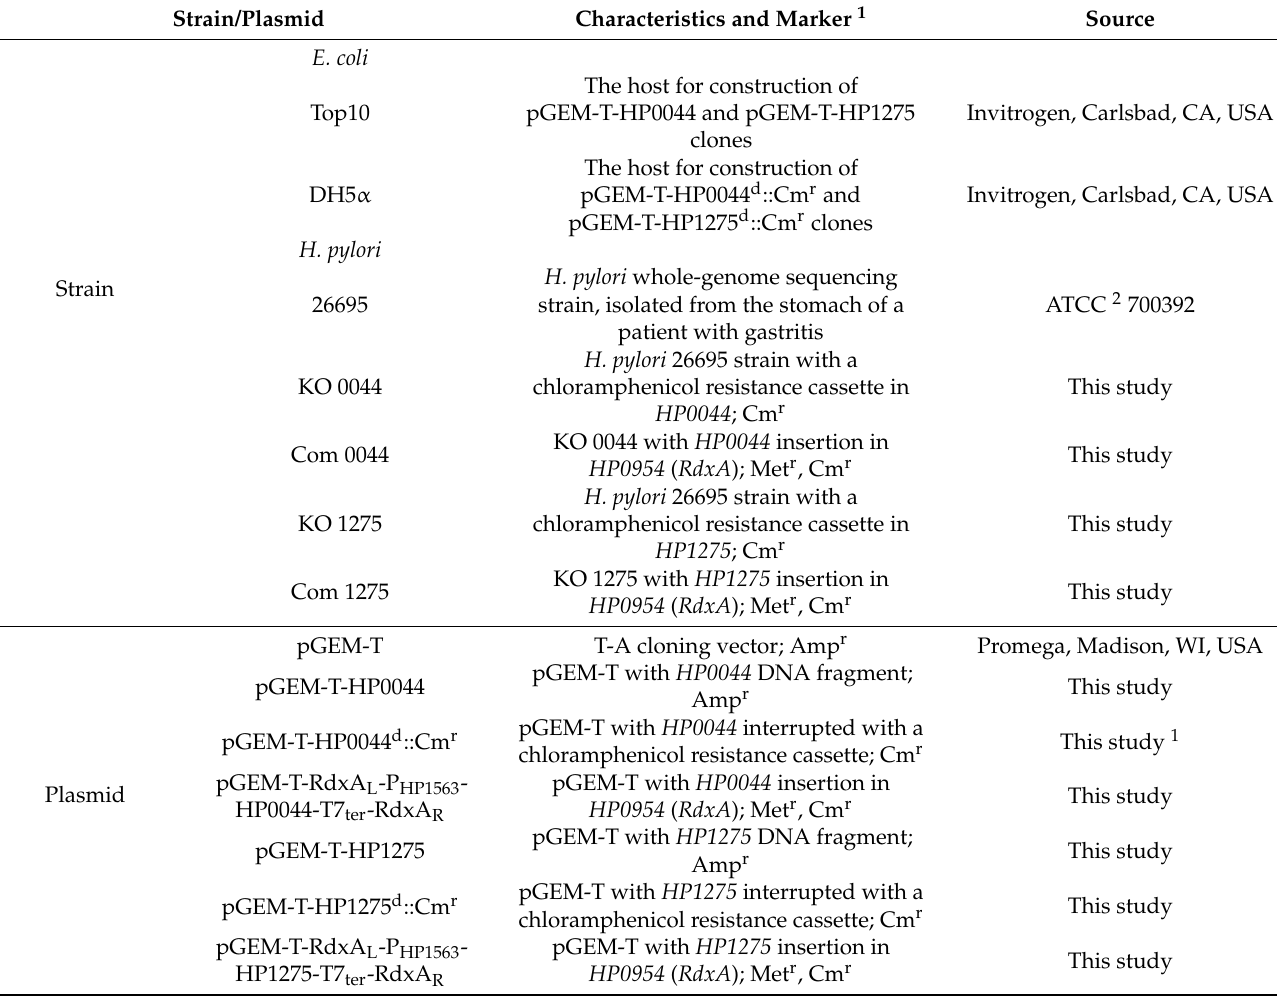
Table 1. Bacterial strains and plasmids used in this